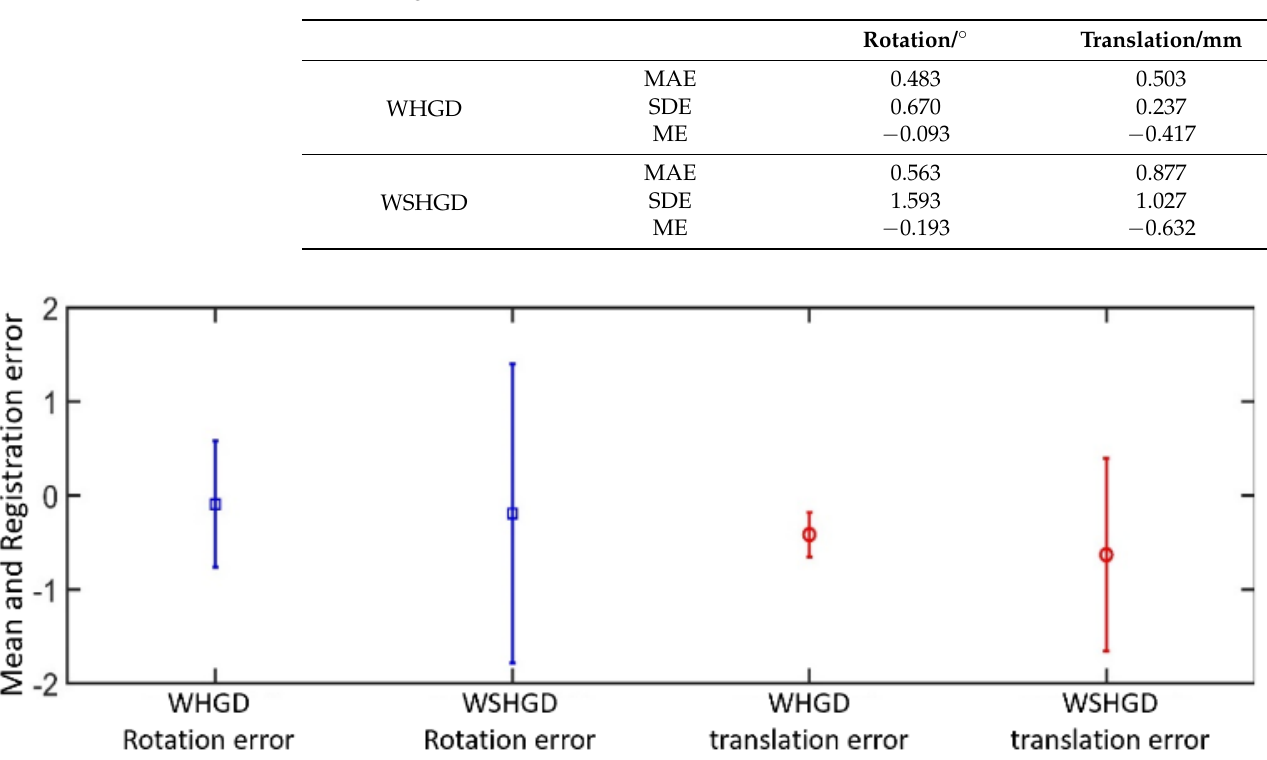
Table 2. Registration results of the WSHGD and WHGD.